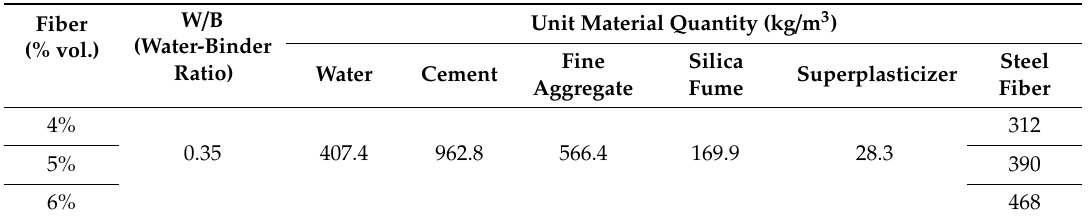
Table 4. SIFRCCs (high-performance slurry-infiltrated fiber-reinforced cementitious composite) mixing proportion.